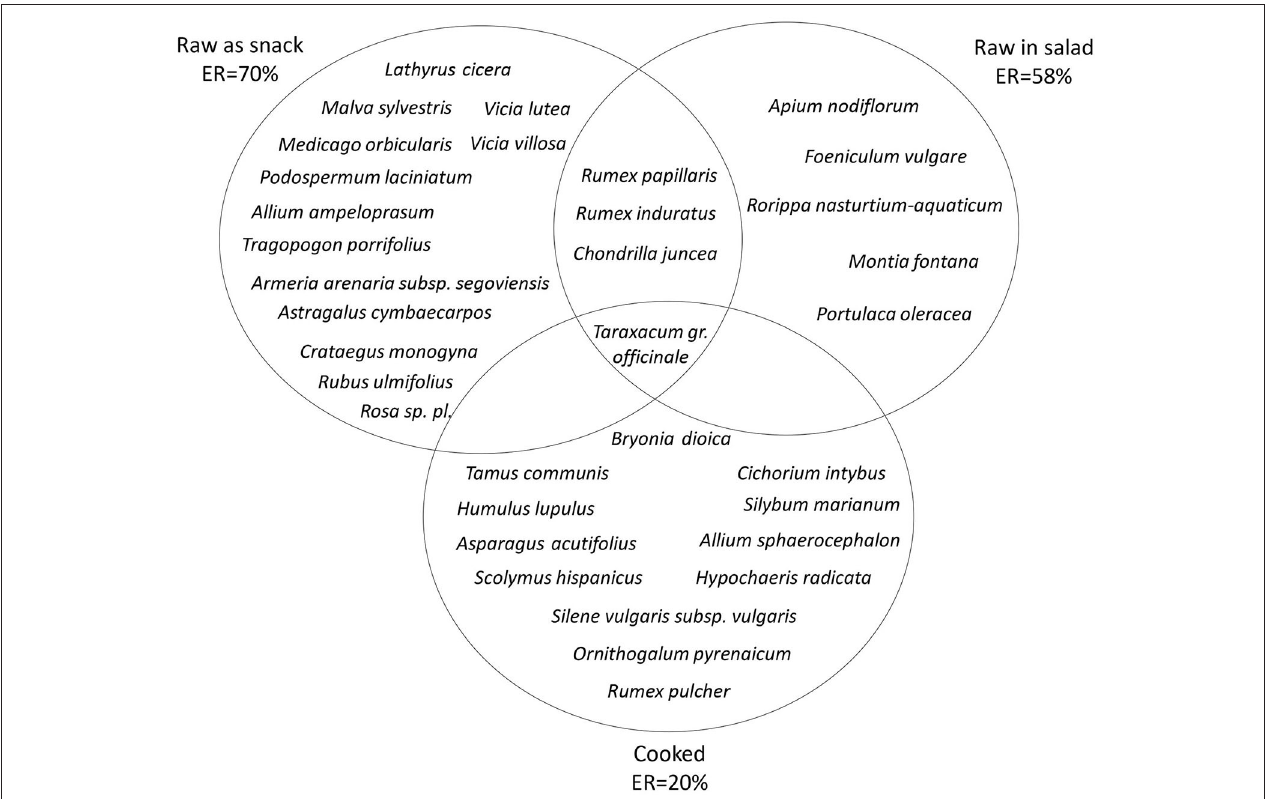
FIGURE 4 | Wild vegetable species consumed in each mode of consumption and their overlaps. The erosion rate (ER) of each group is presented next to the